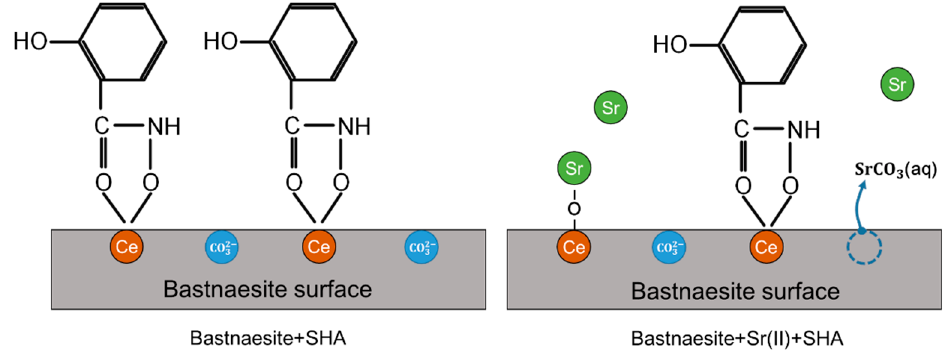
Figure 11. Schematic representation of depression mechanism of strontium ions in bastnaesite flotation with SHA as collector.